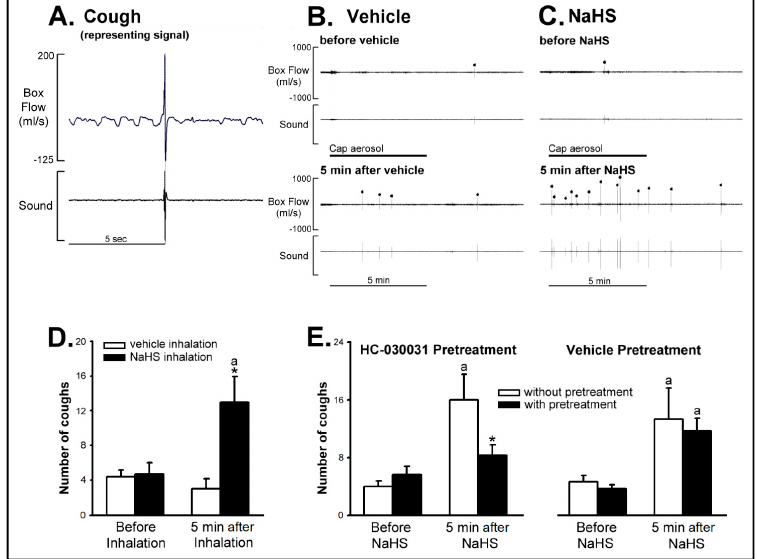
Figure 6. The role of TRPA1 receptors in sodium hydrosulfide (NaHS)-induced enhancement of cough reflex in six groups of awake guinea pigs. ( A ) Experimental record representing a signal of the cough reflex. Vertical bars show the flow changes and the sound signal in the exposure chamber. ( B , C ) Experimental records illustrating the e ff ects of aerosolized vehicle and NaHS on cough response to capsaicin aerosol (30 µ M, 5 min) in two guinea pigs. The duration of capsaicin aerosol delivery is indicated by horizontal bars. Each cough was indicated by the dot on the top. Data are expressed as the total number of coughs observed during a 5-min exposure period and the subsequent 5-min observation period after the end of capsaicin aerosol exposure. Each animal only received two capsaicin-induced cough challenges which were performed seven days apart to avoid tachyphylaxis. ( D ) E ff ects of aerosolized NaHS on cough responses to capsaicin before and 5 min after NaHS inhalation in two groups of awake guinea pigs. Data are means ± SE of six rats. a , significantly di ff erent from before inhalation ( p < 0.05); *, significant di ff erence when corresponding data between vehicle and NaHS inhalation were compared ( p < 0.05). ( E ) Role of TRPA1 receptors in NaHS-induced enhancement of cough reflex in four groups of awake guinea pigs. Data are means ± SE of six rats. a , significantly di ff erent from before NaHS ( p < 0.05); *, significant di ff erence when corresponding data between without and with pretreatment were compared ( p < 0.05). Please note that NaHS-induced enhancement of cough reflex was largely attenuated when guinea pigs were pretreated with